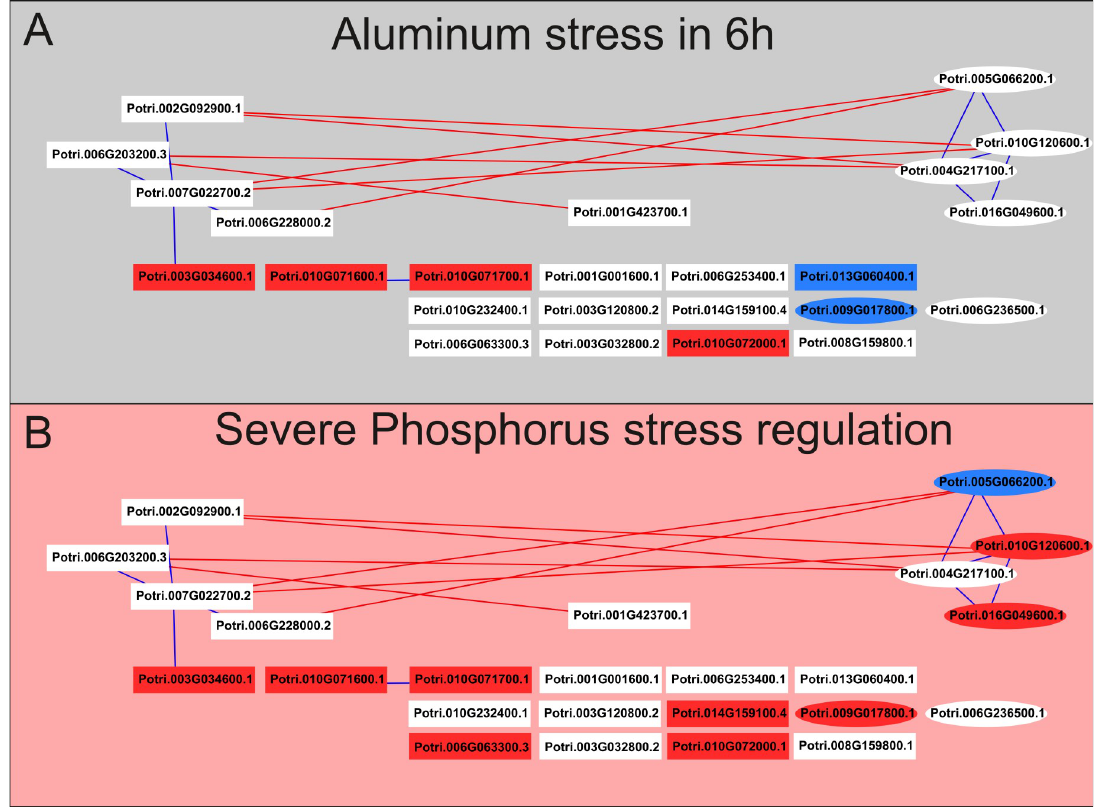
Fig 7. Correlations ( ρ � |0.8|) between genes encoding proteins similar to those responsive to phosphate deficiency (rectangles) and regulated by the transcription factor STOP1 from A . thaliana (ellipses). A- Regulation profile at 6 h of aluminium stress; B- regulation profile under severe phosphate deficiency stress. Green represents positive regulation, and red represents negative regulation; blue lines represent positive correlations, and red lines represent negative correlations.